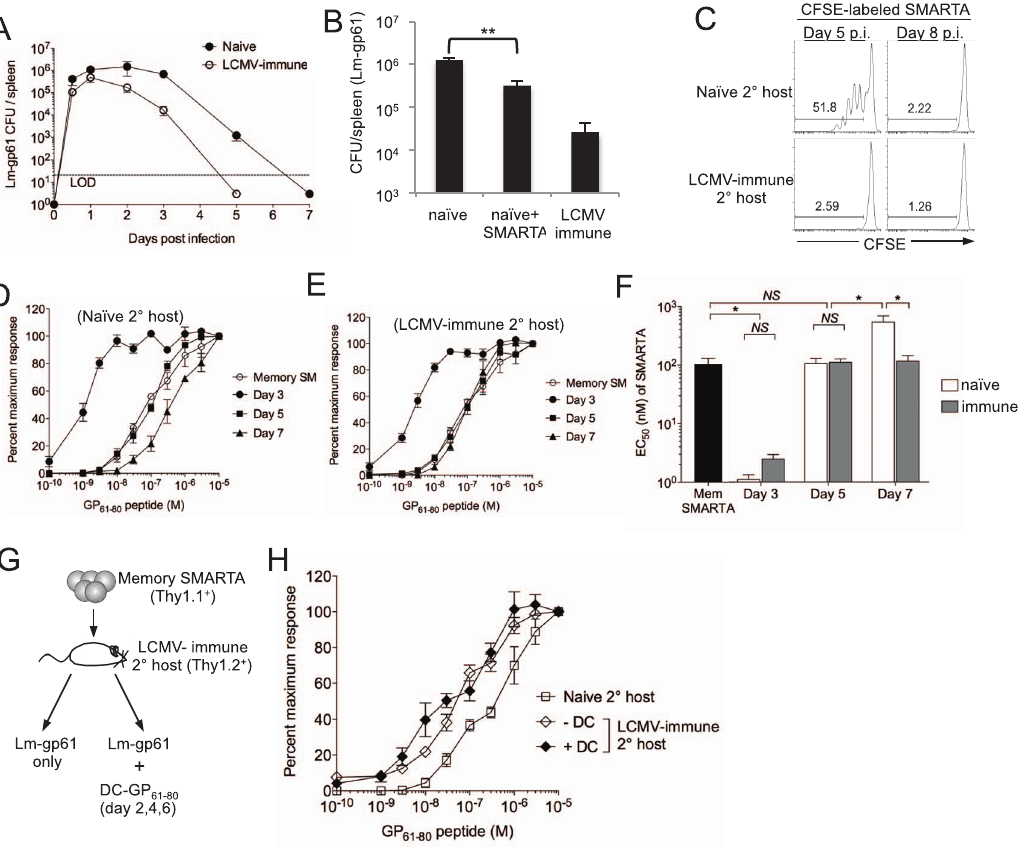
Figure 3. Functional avidity decay of secondary Th1 responders is associated with a prolonged infectious period. A ) Graph displays the CFU detected in the spleen at the indicated time points after challenge of naı¨ve or LCMV-immune mice with Lm-gp61. LOD is limit of detection. B ) Bar graph indicates Lm-gp61 CFU in the spleen day 3 post-challenge of naı¨ve mice, naı¨ve mice that received a prior adoptive transfer of 2 6 10 5 SMARTA memory cells and LCMV-immune mice. C ) Naı¨ve or LCMV-immune mice were infected with Lm-gp61. At either day 5 or 8 post-infection, they were injected with CFSE-labeled naı¨ve SMARTA cells (Thy1.1 + ). Representative flow plots indicate CFSE dilution by gated CD4 + Thy1.1 + SMARTA cells in the spleen 3 days later. D–F ) 1 6 10 5 LCMV-induced memory SMARTA cells (Thy1.1 + , . 42 days post-infection) were transferred into either naı¨ve or LCMV-immune secondary hosts (Thy1.2 + ) and rechallenged with Lm-gp61. The functional avidity of Thy1.1 + SMARTA cells was determined as previously at days 3, 5 and 7 post-infection in naive (D) or LCMV-immune (E) secondary hosts. F ) Bar graph displays EC 50 . G ) 1 6 10 4 Thy1.1 + LCMV- induced memory SMARTA cells ( . 42 days post-infection) were transferred into LCMV-immune or naı¨ve B6 mice (Thy1.2 + ), followed by Lm-gp61 challenge one day later, with or without co-immunization with 1 6 10 6 peptide-loaded DCs on days 2, 4 and post-challenge. H ) Graph displays the functional avidity of secondary SMARTA effector cells in the spleen at day 7 after Lm-gp61 challenge of LCMV-immune secondary hosts with or without DC co-immunization. Error bars indicate the SEM (n=3–4 mice/group). Results are representative of two separate experiments. * p , .05; NS =not significant, as determined by student’s t-test.